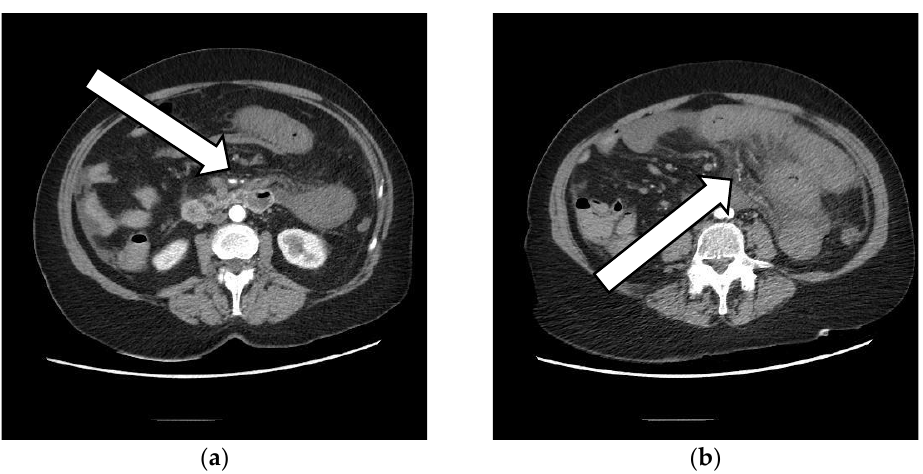
Figure 1. Arterial CT scan showing superior mesenteric artery. ( a ) Arrow is pointing toward the first branch of the superior mesenteric artery that appears to receive normal contrast; ( b ) Arrow is pointing toward distal branches of the superior mesenteric artery that tend to have thrombotic characteristics.